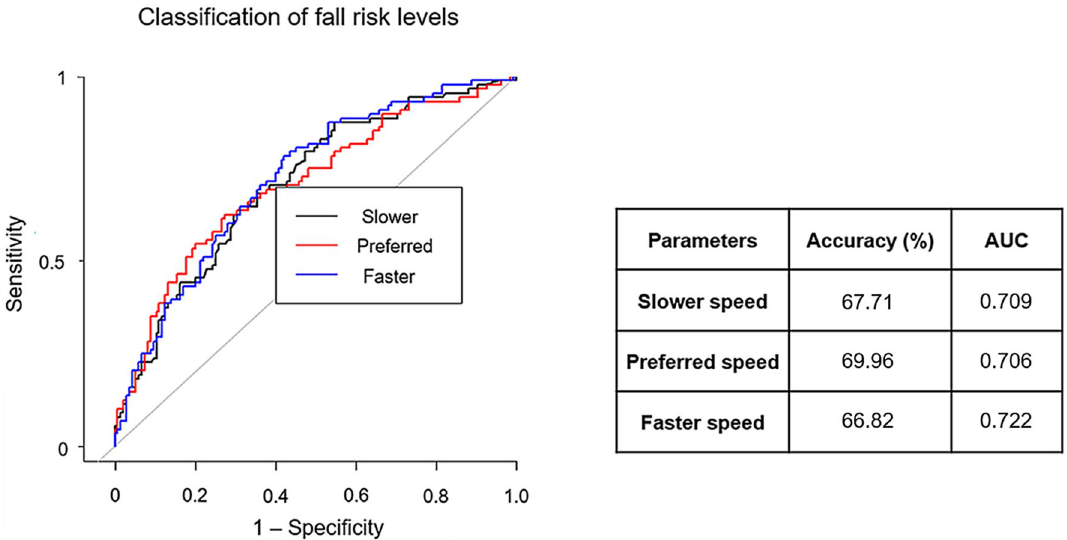
Figure 2. Prediction ability of the XGBoost models for three different walking speeds. ROC curves show the superiority in classifying high vs low level of fall risk. The corresponding values of AUC for each speed are